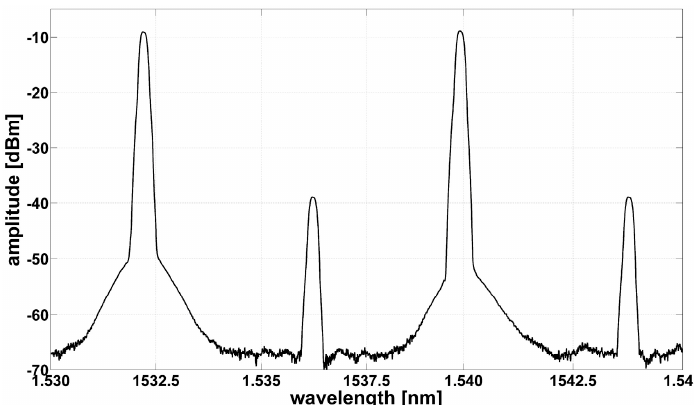
Figure 8. Optical spectra recorded at output port 2 showing the WDM switching operation of the photonic chip.